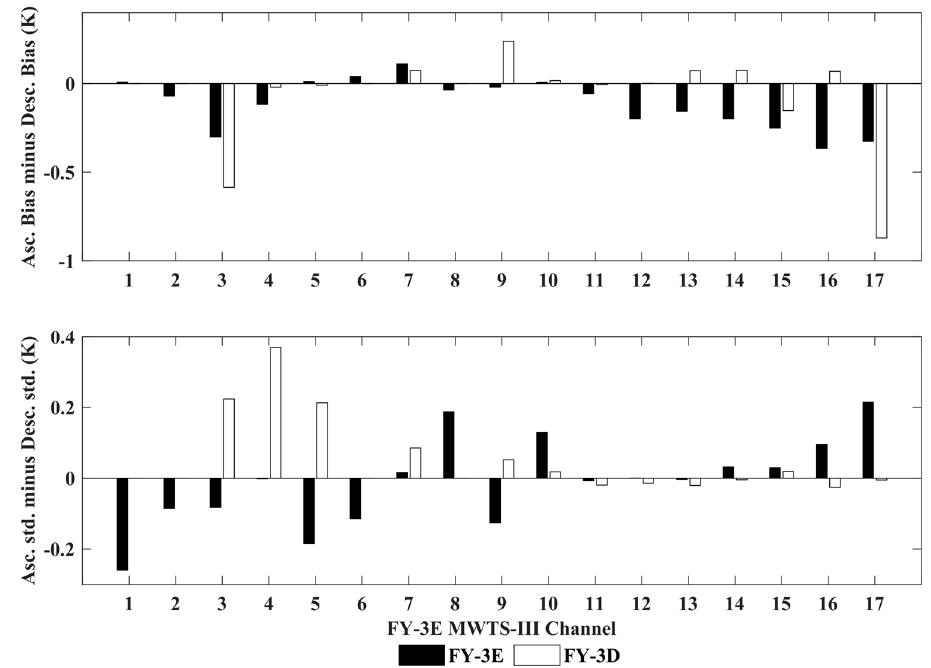
Figure 6. Comparison of the differences in O − B bias and standard deviation (std) of the ascending (asc) and descending (desc) orbits of the equivalent channels of FY-3E MWTS-III (black) and FY-3D MWTS-II (white). x-coordinate is the channel number of FY-3E MWTS-III.